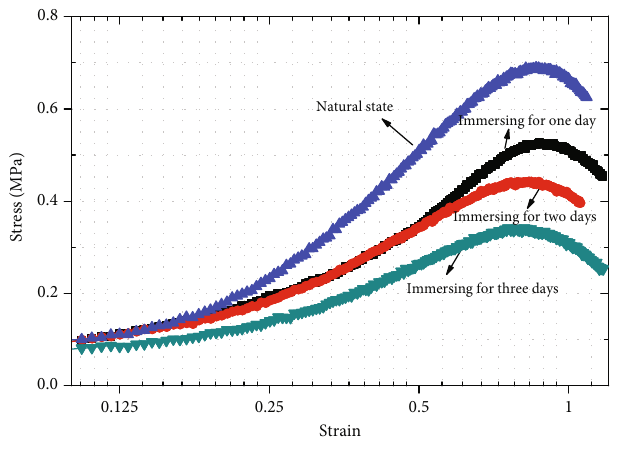
Figure 10: The stress-strain